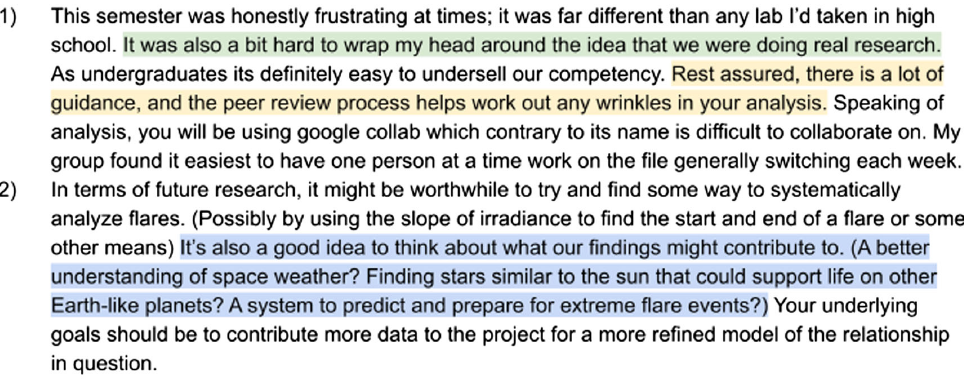
FIG. 4. A portion of Student 3 ’ s response to the memo assignment. Green highlighting corresponds to a direct authenticity code, blue highlighting corresponds to an Indirect authenticity code, and yellow highlighting corresponds to a research components